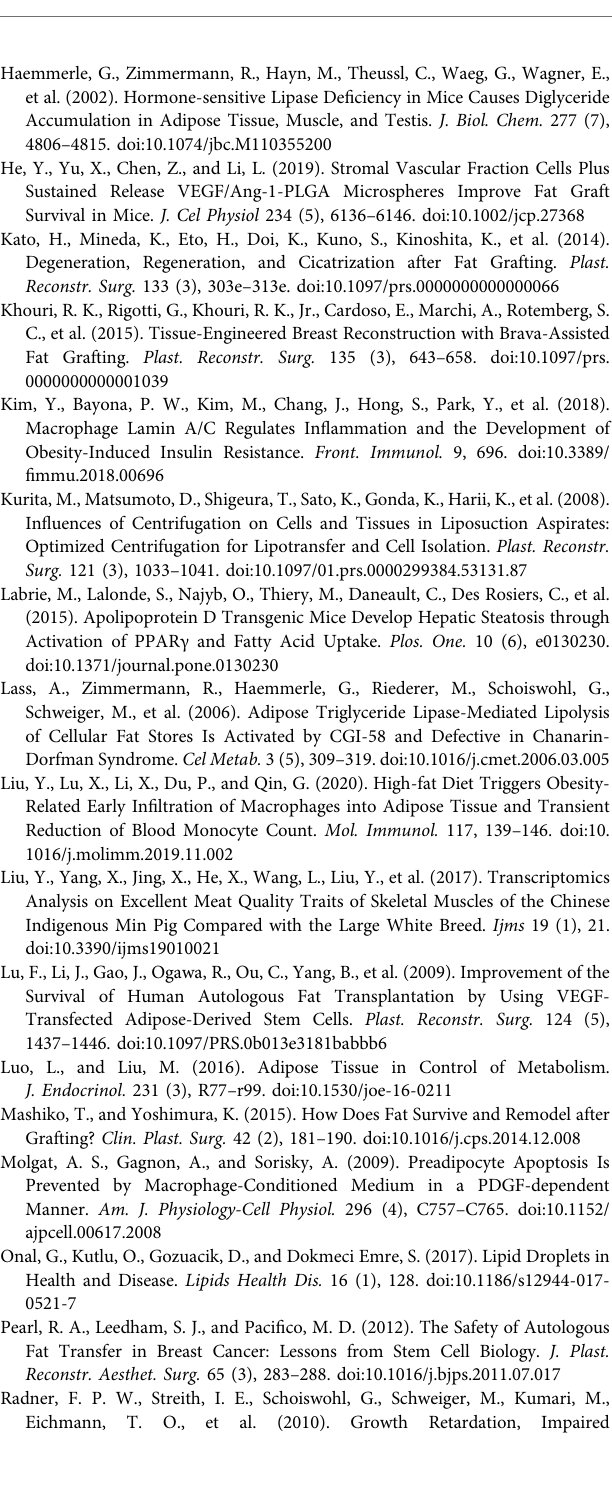
Fat Transfer in Breast Cancer: Lessons from Stem Cell Biology. J. Plast. Reconstr. Aesthet. Surg. 65 (3), 283 – 288.